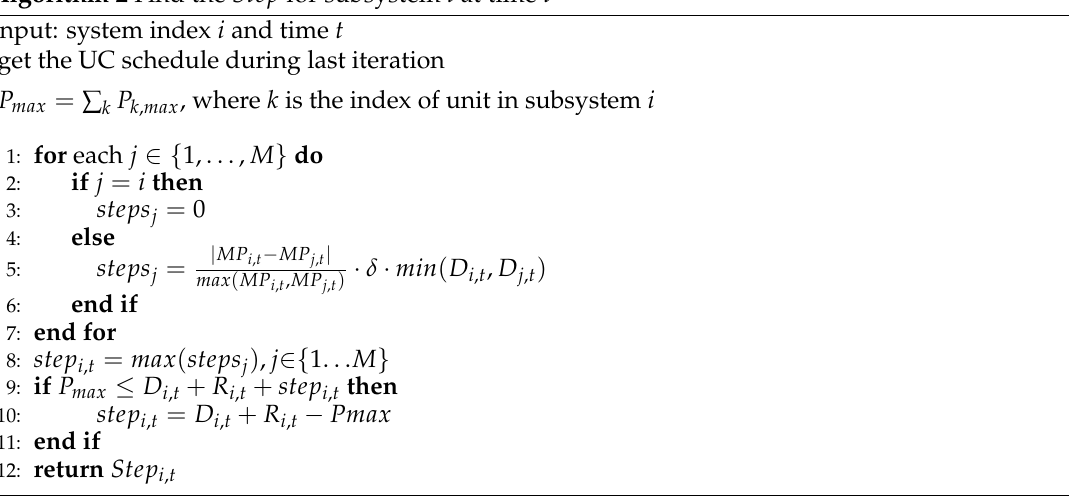
Algorithm 2 Find the Step for subsystem i at time